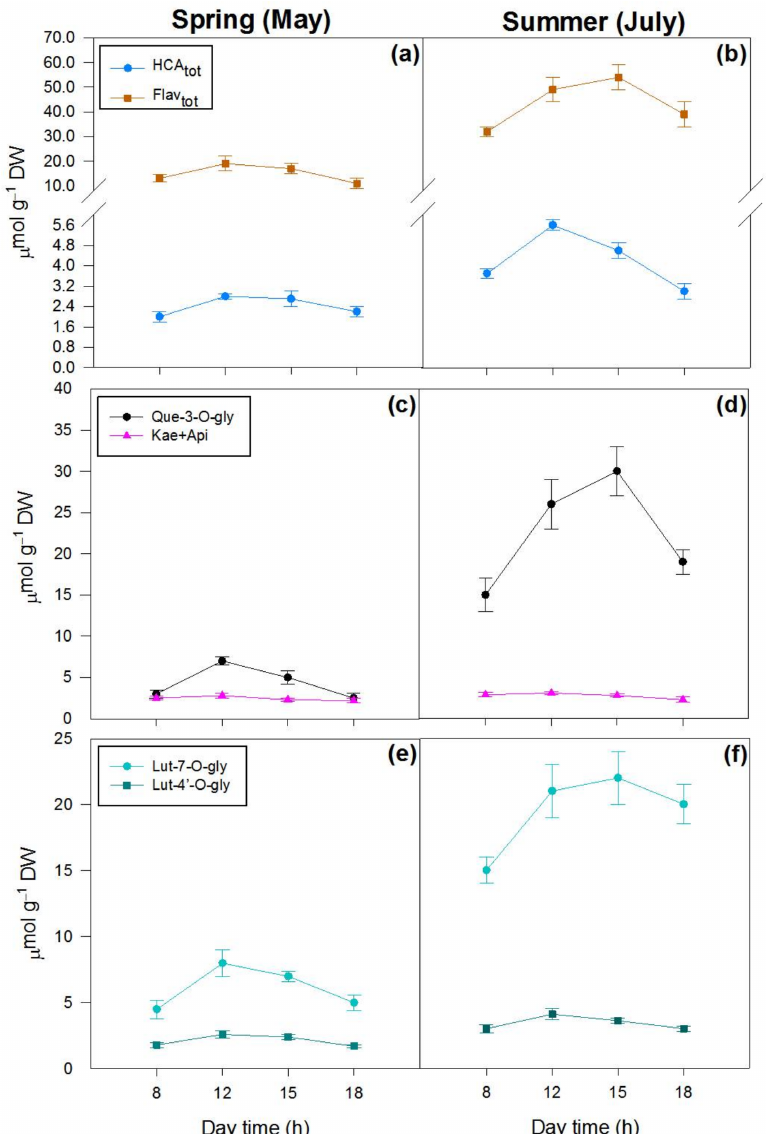
Figure 4. Daily variations in the content ( µ mol g − 1 DW) of phenylpropanoids in spring (( a , c , e )—left) and summer (( b , d , f )—right) leaves of P. latifolia . ( a , b ) Content of hydroxycinnamates (HCA tot ) and flavonoids (Flav tot ); ( c , d ) content of quercetin-3- O -glycosides and kaempferol + apigenin deriva- tives; ( e , f ) content of luteolin-7- O - and luteolin-4 (cid:48) - O -glycosides. Measurements were conducted at 08:00–09:00 (8 h in graph), 12:00–13:00 (12 h), 14:30–15:30 (15 h) and 17:30–18:30 (18 h) hoursontwo dates in spring (11–12 and 25–26 May) and summer (4–5 and 22–23 July) on clear days. Data are reported as means ± SD ( n =